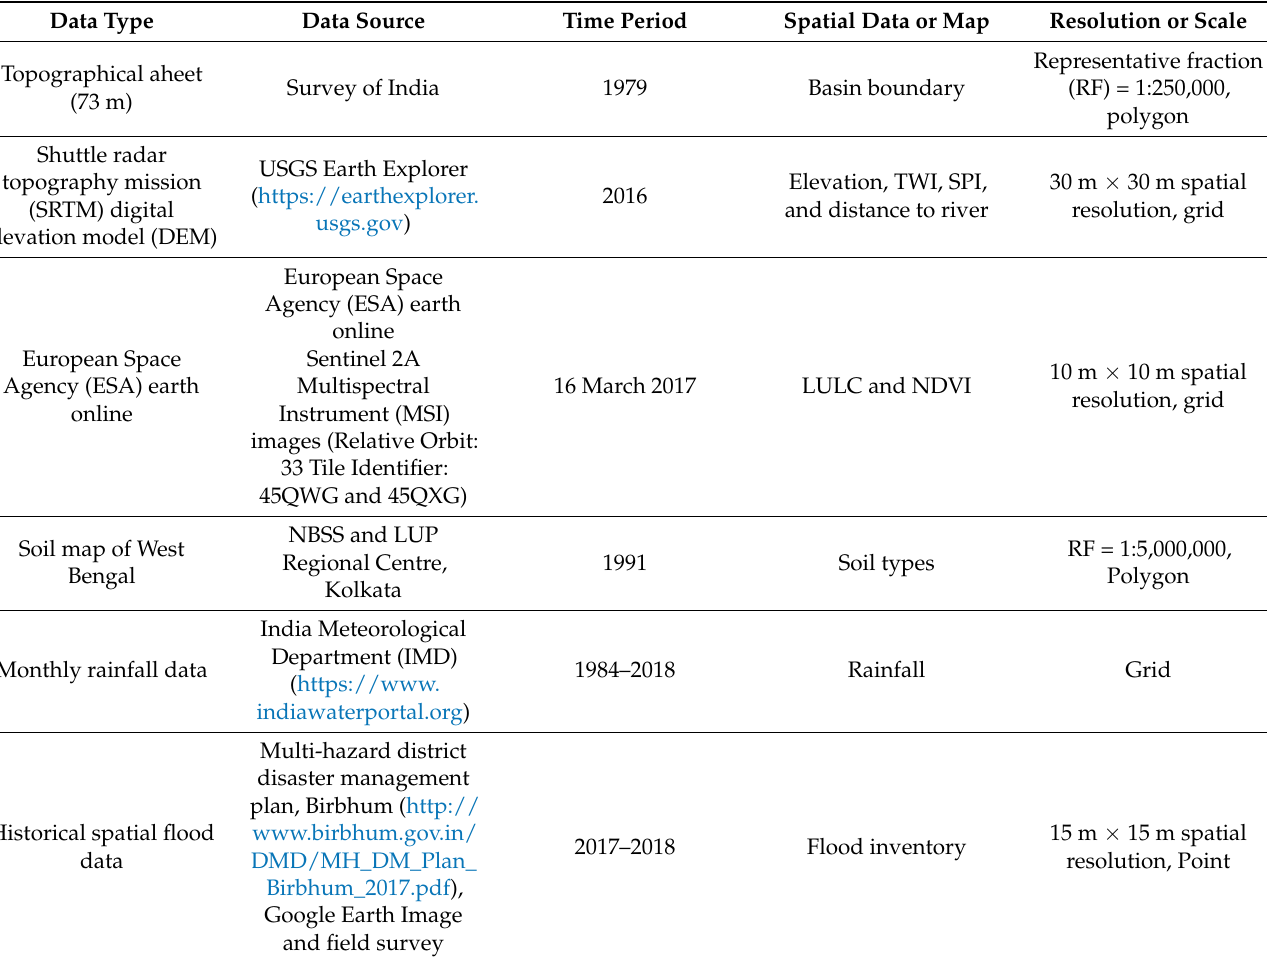
Table 1. Details description about the data used in the